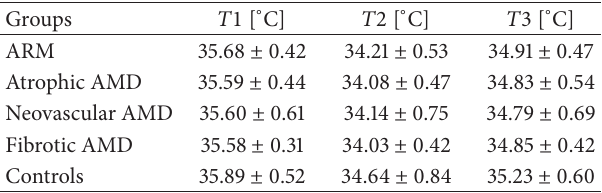
Table 1: Ocular surface temperature of all three points expressed as means ± one standard deviation for AMD groups and controls.